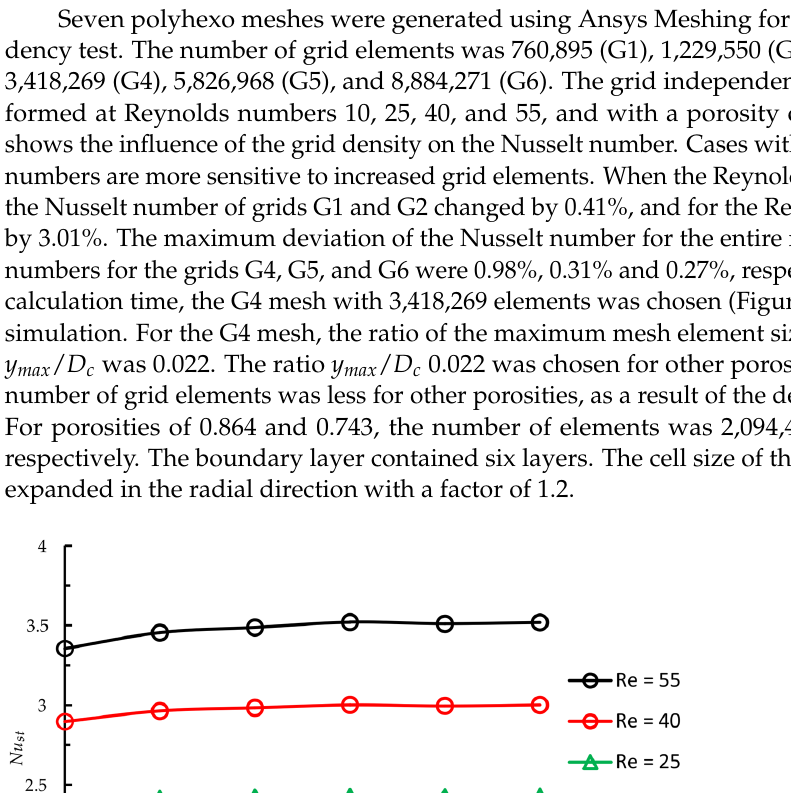
Figure 5. The Voronoi foam grid (G4). To verify the numerical simulation, the Nusselt number obtained for the steady flow at a porosity of 0.954 was compared to the experimental data of other authors. Figure 6 shows the Nusselt number obtained from the numerical simulations and empirical corre- lations proposed by Mancin et al. [56] and Calmidi et al. [57]. As can be seen from Figure 6, there is a good agreement between the Nusselt numbers and the data from Mancin et al. [56] and Calmidi et al. [57]. The difference between numerical simulation and experi- mental data from [56,57] was less than 9%.